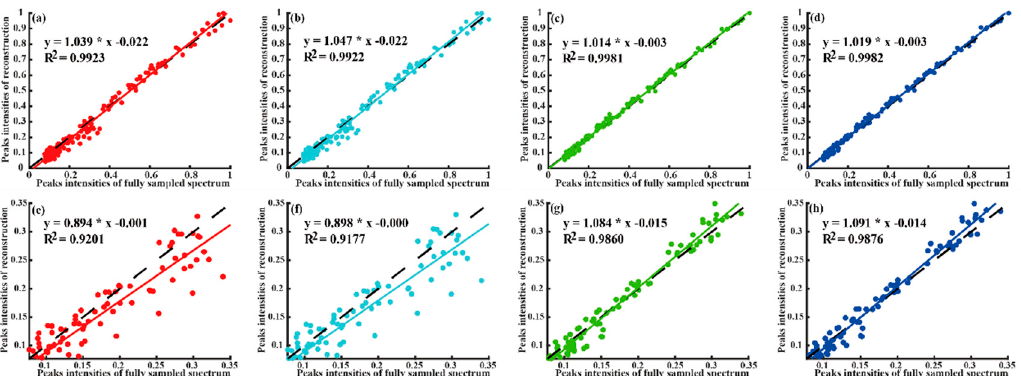
Figure 8. Peak intensity correlation between fully sampled spectrum and reconstructed spectra on the 2D 1 H- 15 N best-TROSY spectrum of ubiquitin. ( a – d ) are correlation plots of all peaks using LRHM, LRHMF, SLS, and SLSMF, respectively. ( e – h ) are correlation plots of low-intensity peaks using LRHM, SLS, and SLSMF, respectively.